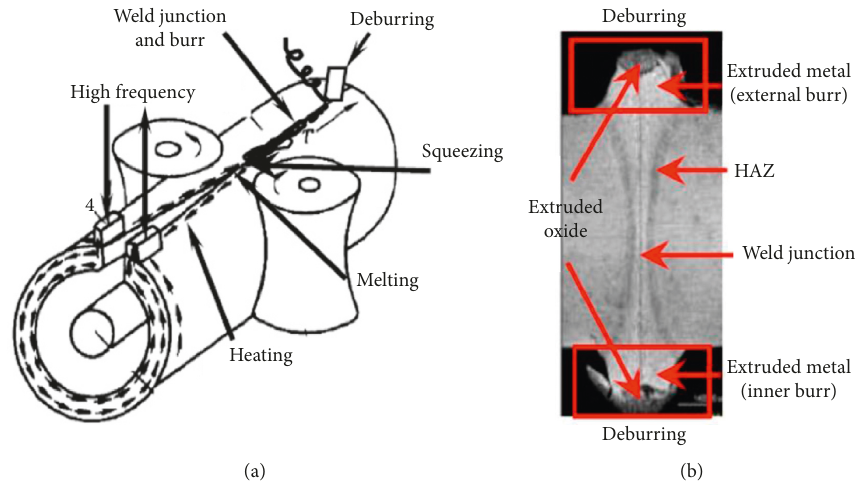
Figure 8: Schematic illustrates (a) the welding processes and (b) the structure of weld